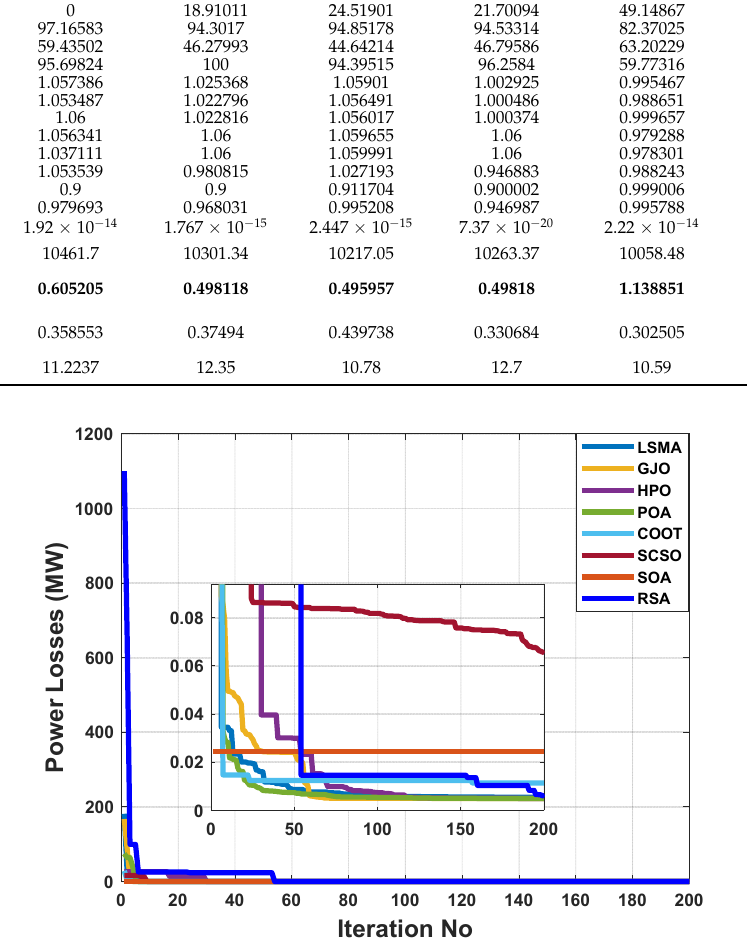
Figure 8. Boxplot of POA and other compared algorithms for case 2 in a standard IEEE 14-bus test system. Case 3: Voltage Deviation Minimization The aim function to be improved using the POA algorithm in this part is decreasing voltage deviation. In Table 4, it is shown that the voltage deviation index is brought down to 0.032 pu by employing the POA algorithm. The POA method significantly outperforms other population-based optimization strategies in Table 4 and Figure 9 when comparing solutions obtained using these methods. Figure 10 illustrates the voltage profiles of all buses using different proposed methods. Figure 11 displays the boxplots for minimizing the voltage deviation with the lowest values by the proposed POA algorithm.